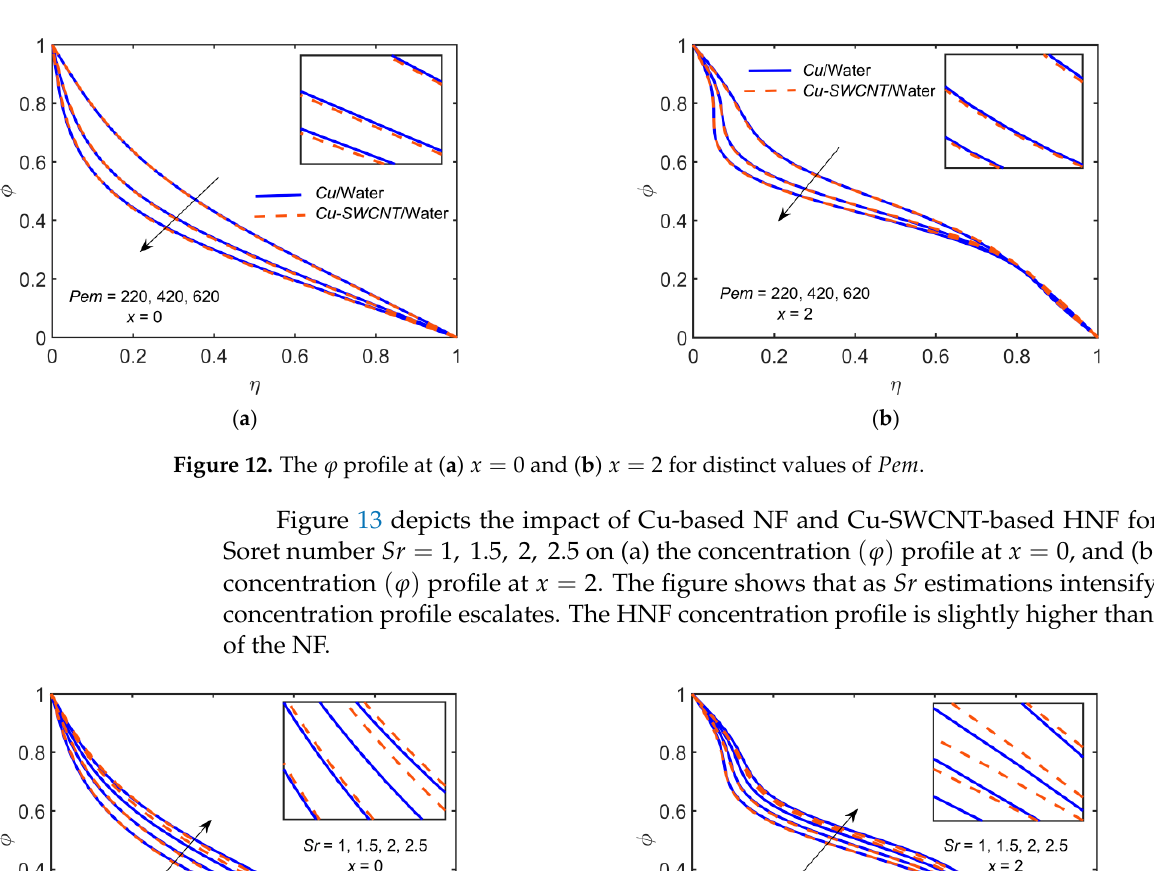
Figure 14 depicts the effect of various flow governing parameters on Nusselt number 𝑁𝑢 . The 𝑁𝑢 escalates as 𝛽 , 𝑅𝑒 , and 𝑃𝑒ℎ estimations intensify. 𝑁𝑢 reduces upon esca- lating 𝑀 , 𝐷 (cid:3028) , and 𝑅𝑑 . ( a )